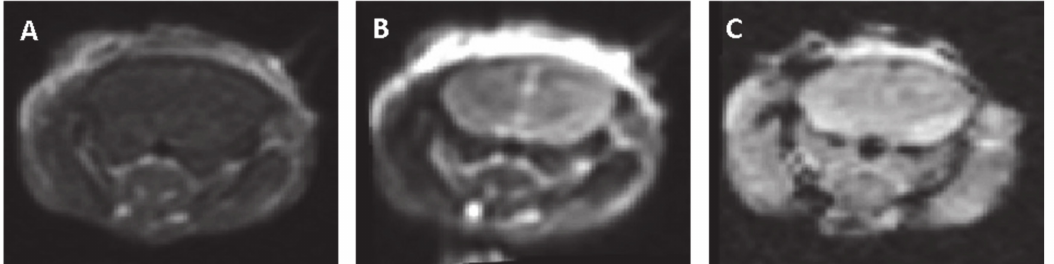
Figure 6. Representative MRI slices obtained 48 h post-pulsed electrical fields (PEFs) application (100 pulses at 300 V) ( A ) . Contrast-enhanced T1-MRI. ( B ) T2-MRI. ( C ) Gradient echo (GE)